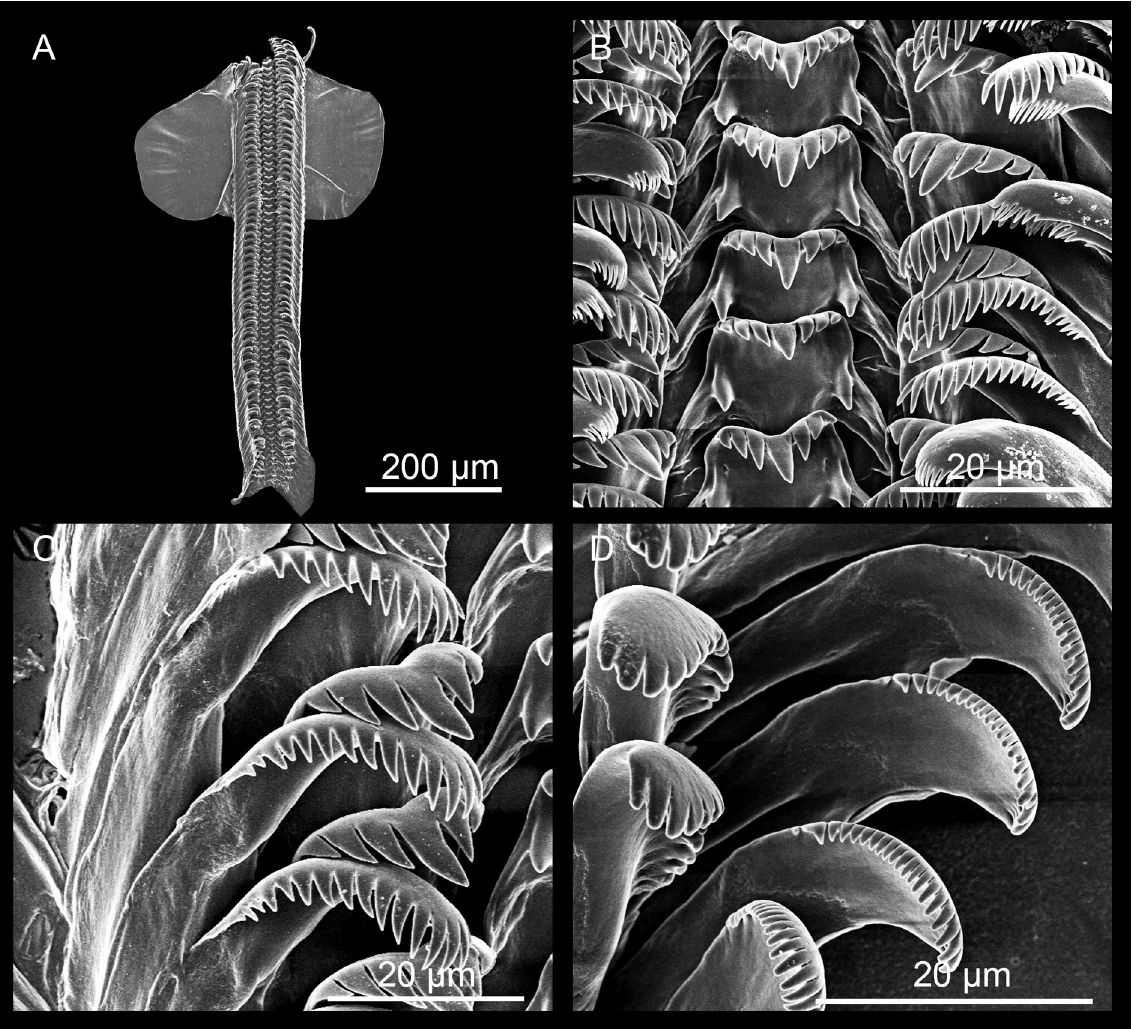
Fig. 27. Radula of the Mercuria lupiaensis Miller & Delicado sp. nov. from Giammateo Creek, Frigole, Lecce. A . General view of the radular ribbon. B . Overview of radular teeth rows. C . Detailed view of the lateral and inner marginal teeth. D . Detailed view of the outer marginal